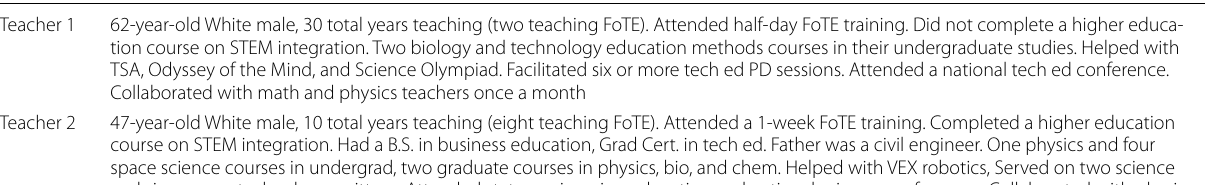
Table 2 Characteristics of observed participants